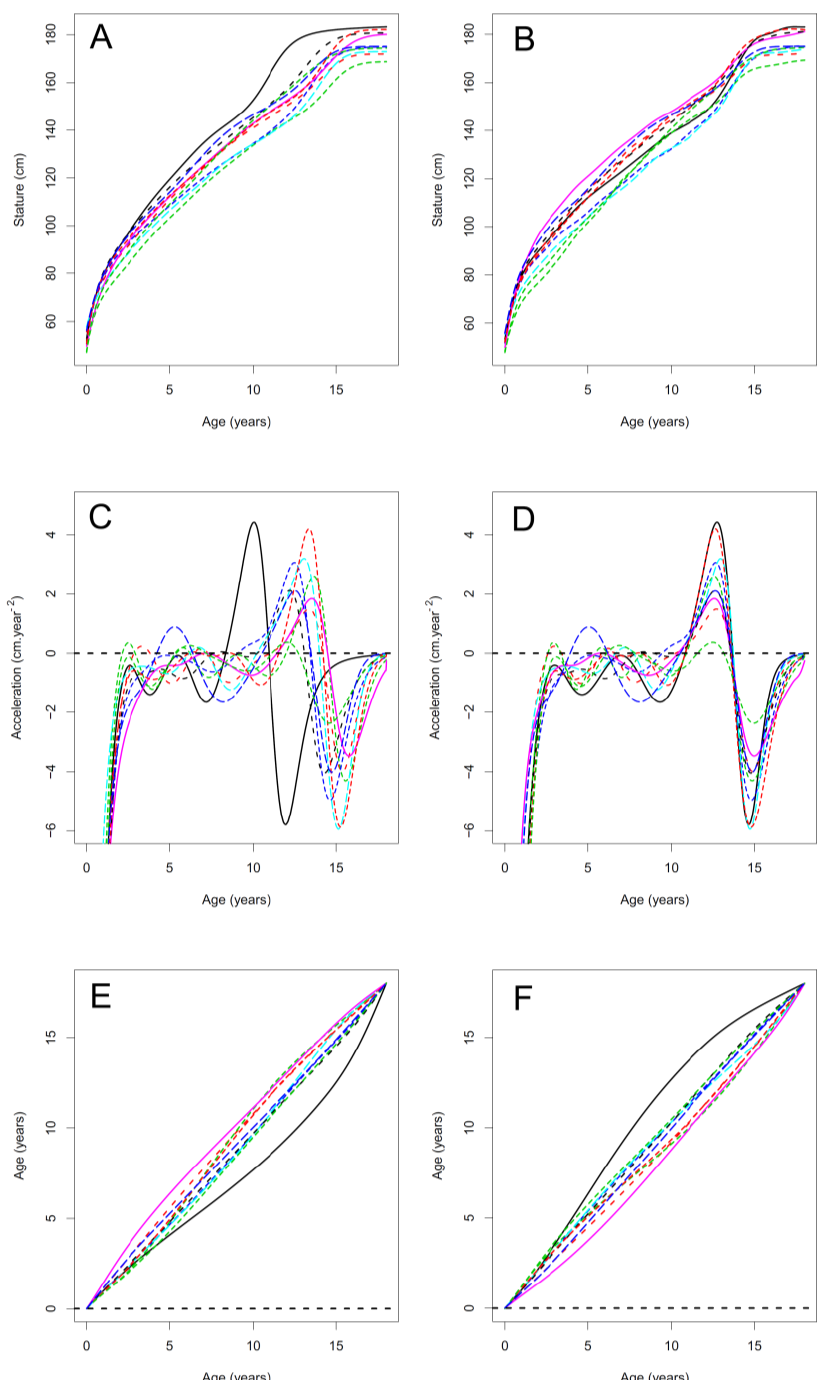
Figure 3. Analytical procedure of the first Functional Data Analysis in an example of te n individual trajectories: ( A ) original distance curves (B-splines), ( B ) individual distance curves after registration (warping) to identical phase (warped to identical APV, i.e., mean population APV), ( C ) individual acceleration curves corresponding to the distance curves in the plot A, ( D ) identical acceleration curves after registration of the phase corresponding to the distance curves in the plot B, ( E ) time-warping functions, ( F ) inverse time-warping functions. The course of the analysis can be described: from ( A ), ( C ) is determined, this is registered to ( D ), then E is extracted and applied to A to be warped to B. ( F ) (inverse time-warping function) is used in the reverse process for generating artificial curves applied in the fitting and growth estimation of new data.